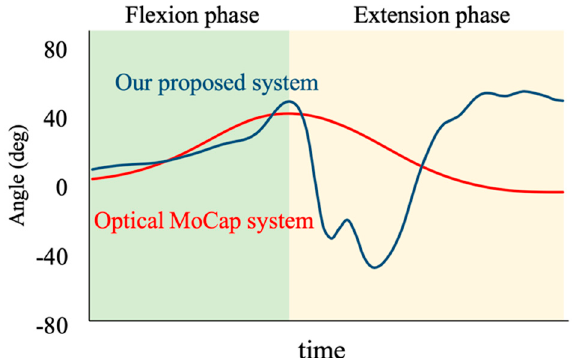
Figure 4. Typical time-series data of trunk flexion–extension angle obtained by our proposed system and optical motion capture (MoCap) system. Trunk flexion and extension excursions were calculated as the maximum displacement in the flexion and extension phase in each system.